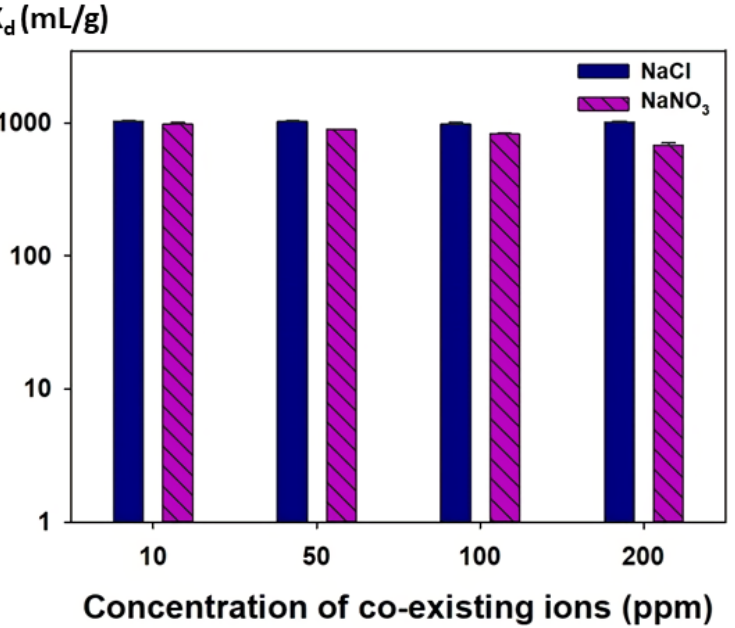
Figure 14. Distribution coefficients ( K d ) of I − at different NaCl and NaNO 3 concentrations on mag@silica-Ag composite.